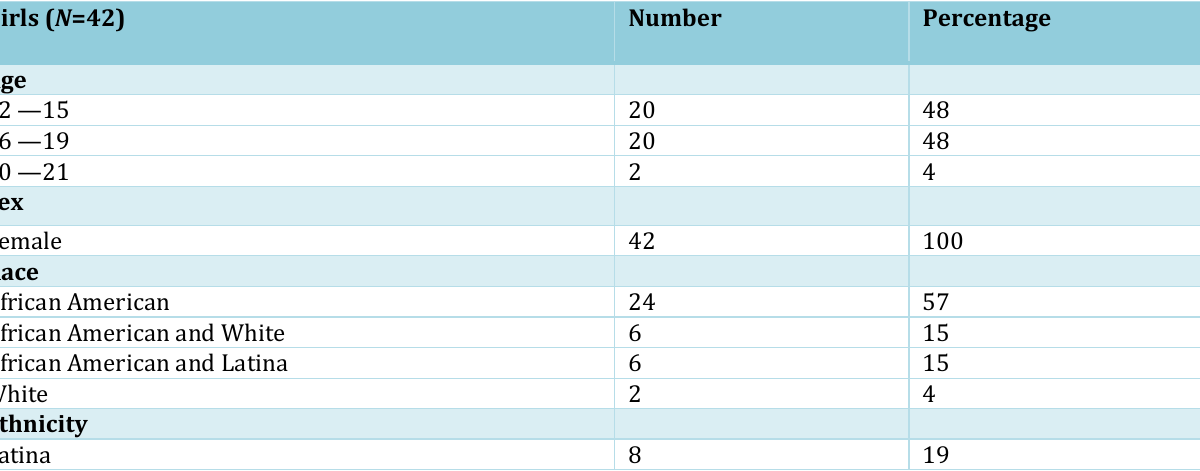
Table 1. Girls’ demographics